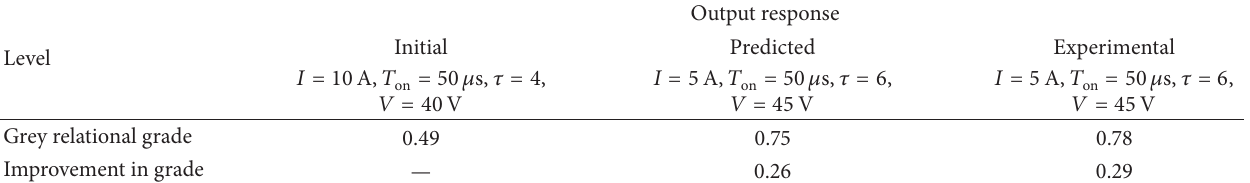
Table 6: Confirmation test.